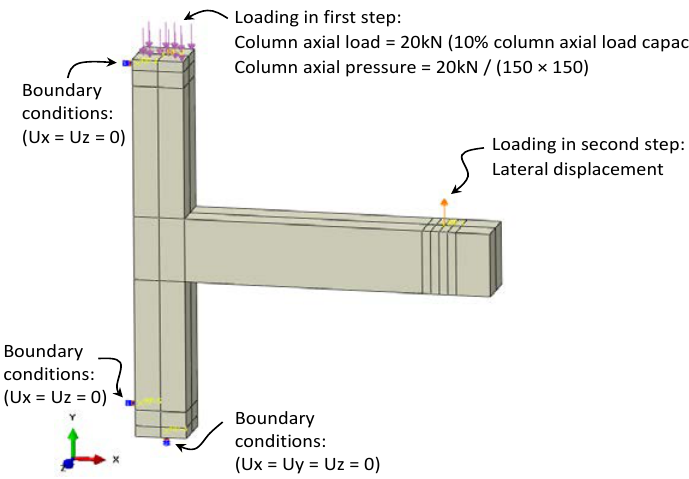
Figure 5. Tested joints boundary conditions and loadings.